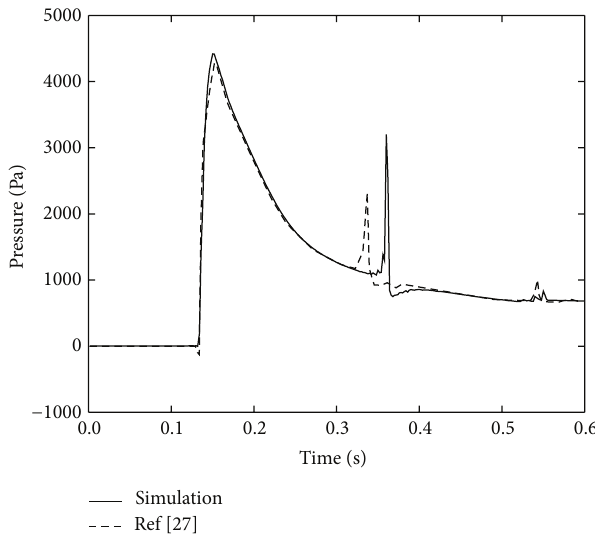
Figure 10: Pressure at the monitored